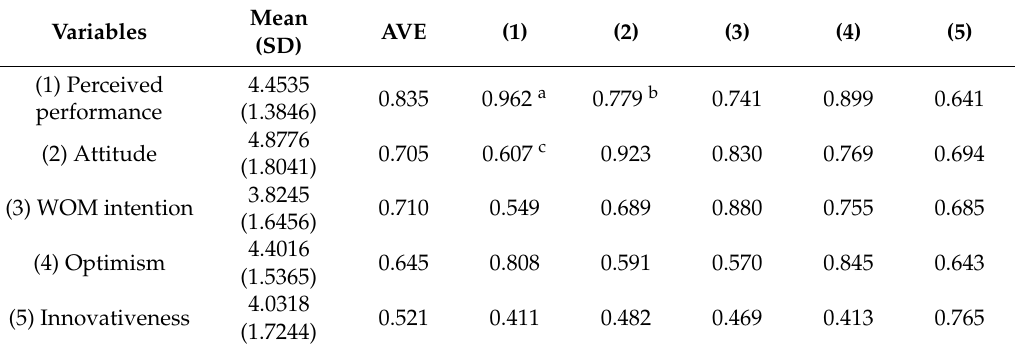
Table 2. Descriptive statistics of the constructs and